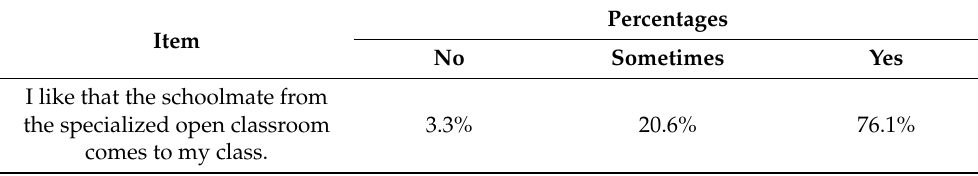
Table 5. Descriptive statistics of the attitudes of the students in the reference classrooms.